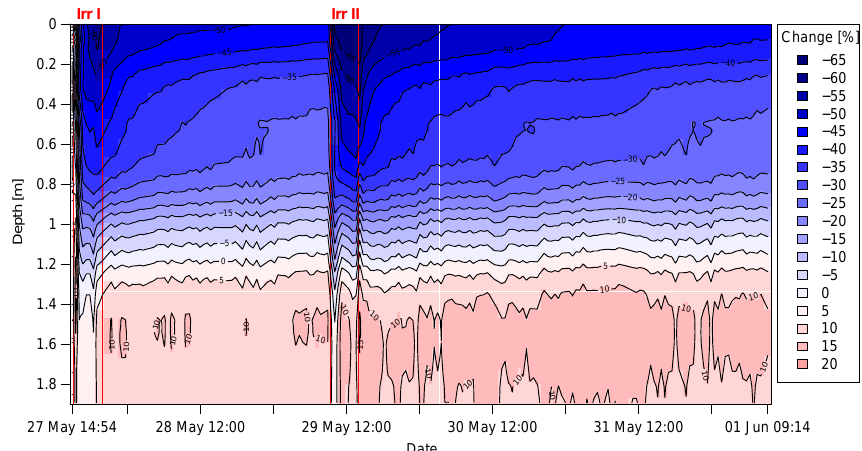
Figure 8. Chronological sequence of resistivity change relating to the initial model of a 1-D depth profile centrally beneath the irrigation area.